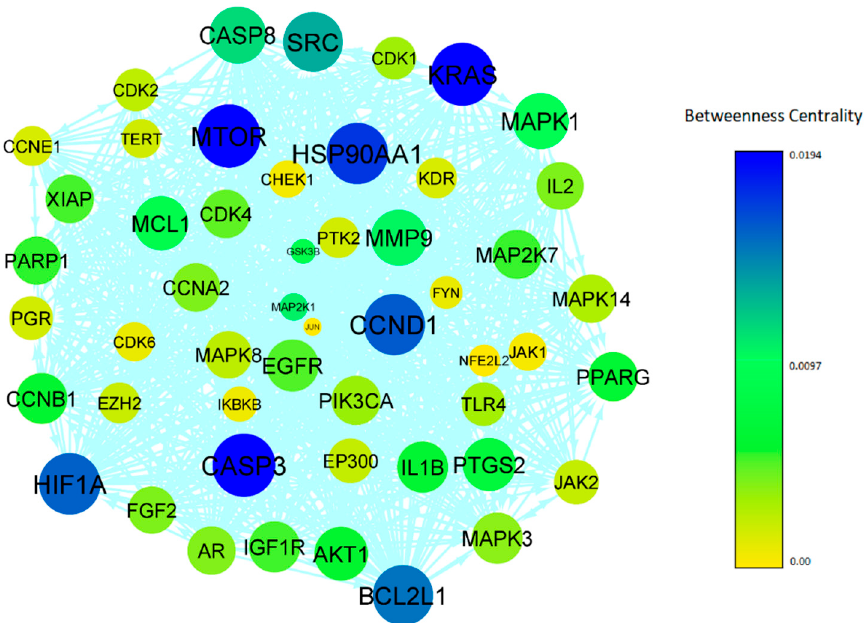
Figure 9. The network of the core target genes. A single network with 51 target genes and 855 edges was created by combining the target genes retrieved from MCODE and Cyto-hubba. The 51 target genes were imported into the DAVID database to enhance KEGG pathways that generated the network of the core target genes.